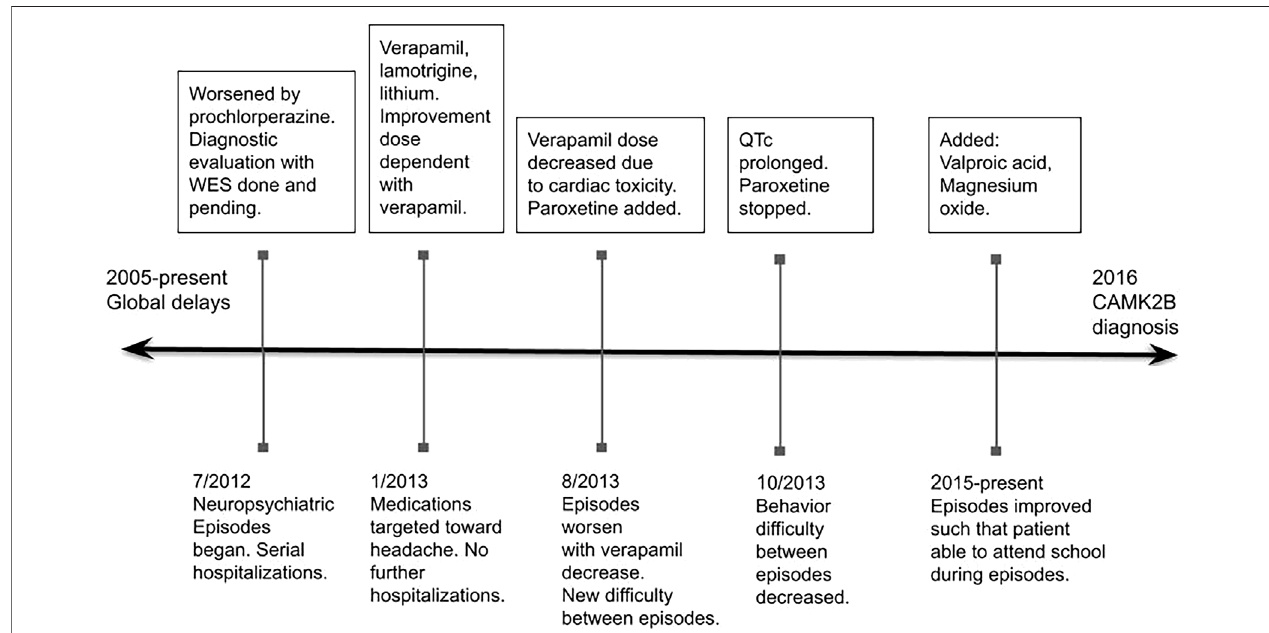
FIGURE 1 | Abbreviations: WES, whole exome